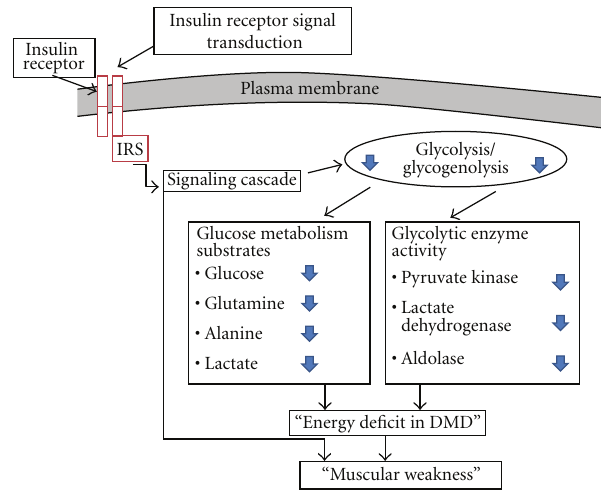
Figure 3: Some aspects of impaired glucose metabolism in patients with childhood muscular dystrophies. The damage in the glucose metabolism, no matter the reason, may probably be one of the causes for energy deficit in DMD patients, and this low energy could result in muscular weakness in muscular